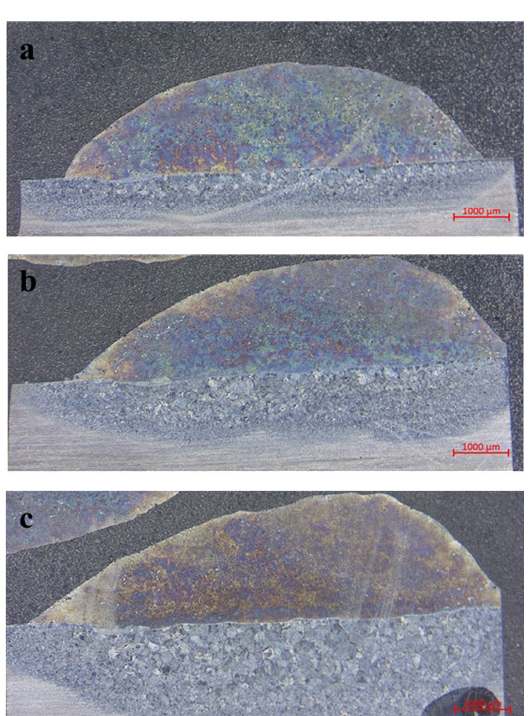
Figure 1. Stereo Microscope Images for samples fabricated at laser power of (a) 800 W, (b) 1000 W and (c) 1200 W.